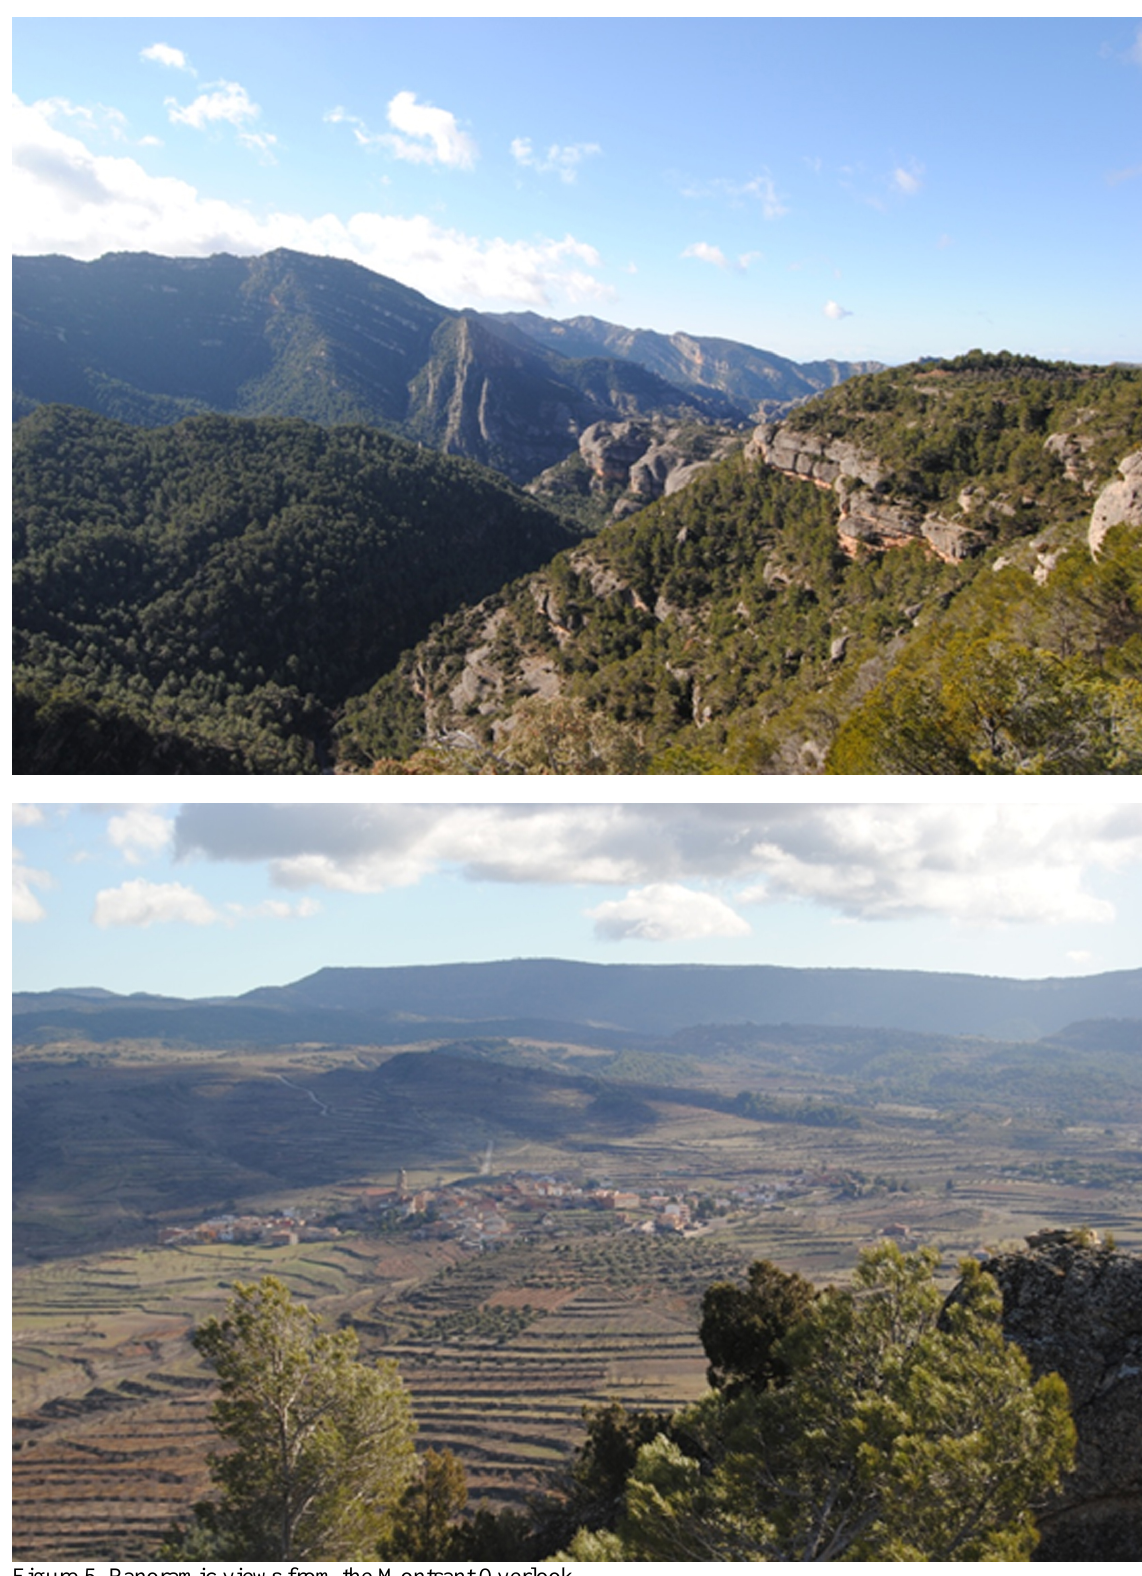
Figure 5. Panoramic views from the Montsant